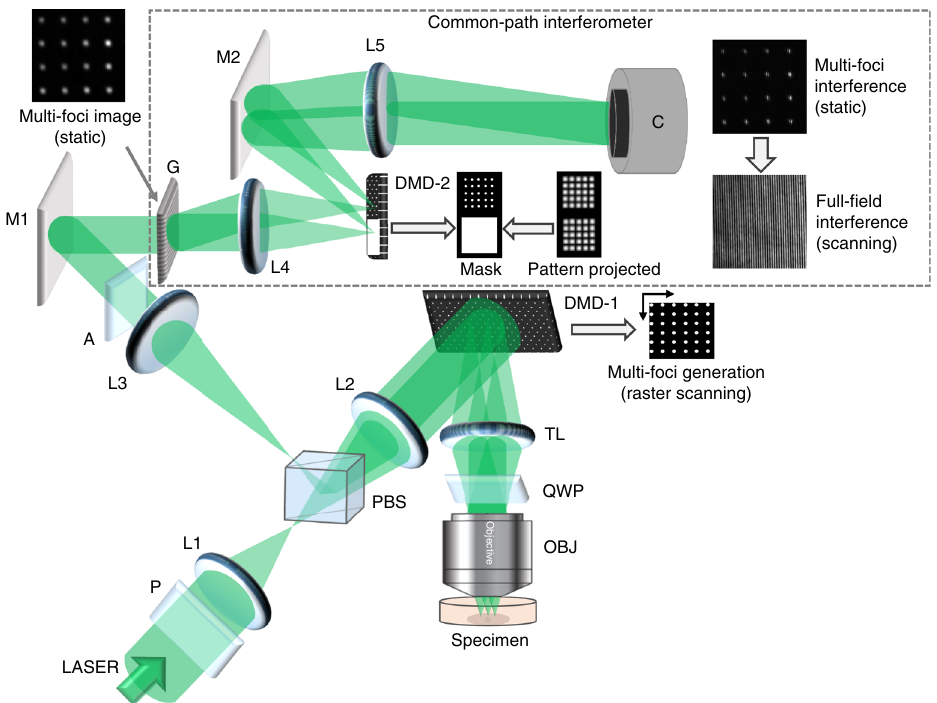
Fig. 1 Schematic of the confocal re fl ectance interferometric microscope. Digital micro-mirror device, DMD-1, is used to create scanning rectangular array of pinholes for high-speed (millisecond frame rate) confocal imaging of the specimen. Detection of depth-resolved optical phase is achieved using the common-path interferometer. P polarizer, L1 – L5 convex lenses (L1 = L2 = L3 = 300 mm, L4 = 100 mm, L5 = 500 mm), PBS polarizing beam splitter, DMD digital micro-mirror device, TL tube lens (165 mm), QWP quarter wave plate, OBJ microscope objective (Zeiss, × 40×/1.2), A analyzer, M1 – M2 mirrors, G grating (80 lines pairs/mm), and C